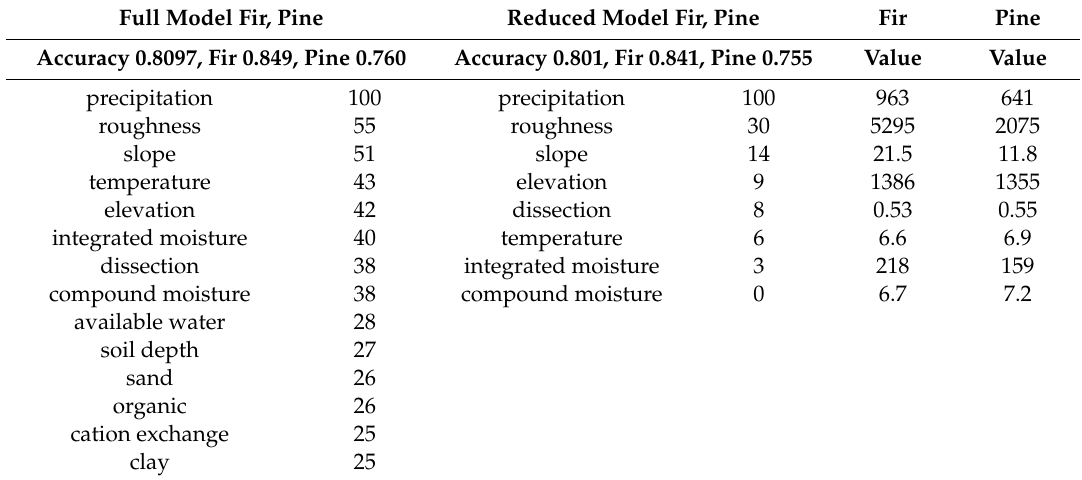
Table 2. Importance of variables and relative importance for full models with soil variables (most influential 14 of the 19 variables) and reduced models without soil variables, and value of variables, for the random forests (rf) model to classify di ff erences between fir and